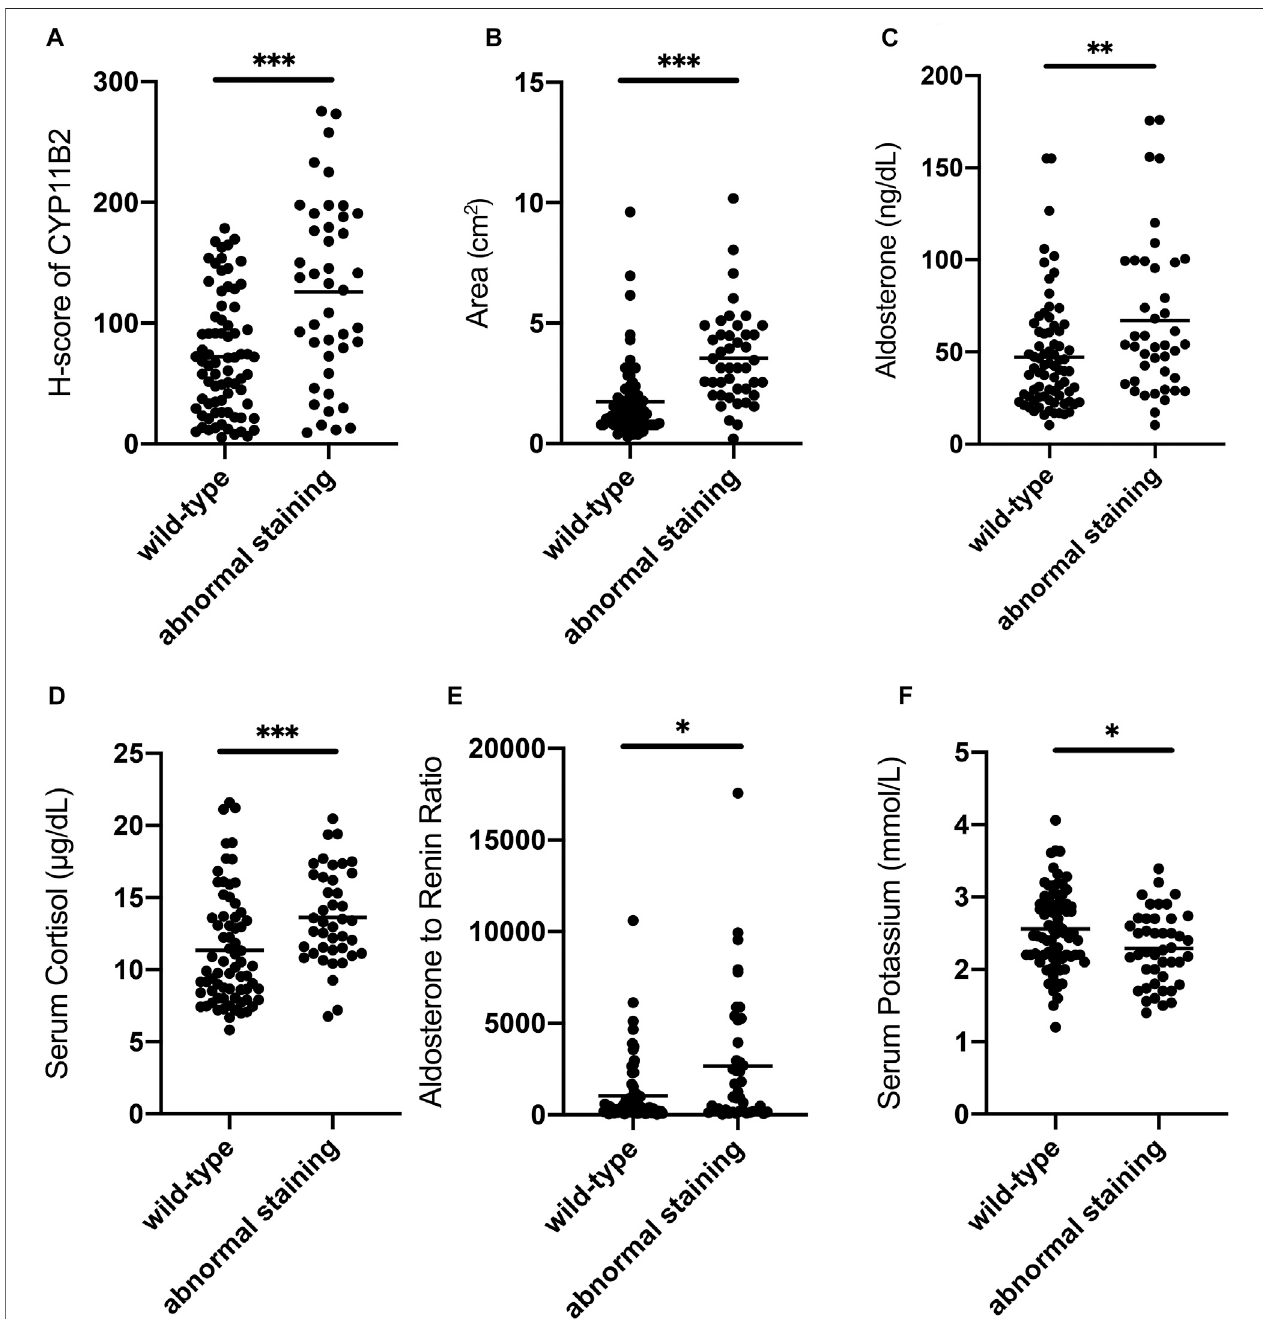
FIGURE 2 | Comparison of clinical characteristics between wild-type staining and abnormal staining groups of β -catenin in patients. (A) CYP11B2 H-score of the abnormal staining group is signi fi cantly higher than that of the wild-type staining group. (B) Tumor area of the abnormal staining group is signi fi cantly higher than that of the wild-type staining group. (C) Serum aldosterone of the abnormal staining group is signi fi cantly higher than that of the wild-type staining group. (D) Serum cortisol of theabnormalstaininggroupissigni fi cantlyhigherthanthatofthewild-typestaininggroup. (E) ARRoftheabnormalstaininggroupissigni fi cantlyhigherthanthatof the wild-type staining group. (F) Serum potassium of the abnormal staining group is signi fi cantly lower than that of the wild-type staining group. Bars in the fi gure represent the median of each group data. * p < 0.05, ** p < 0.01, *** p < 0.001.